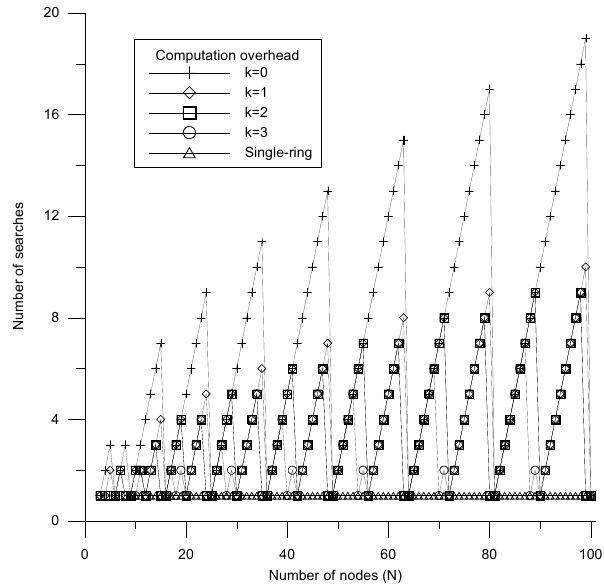
Figure 7. Computation overhead of min-path algorithm for various N .